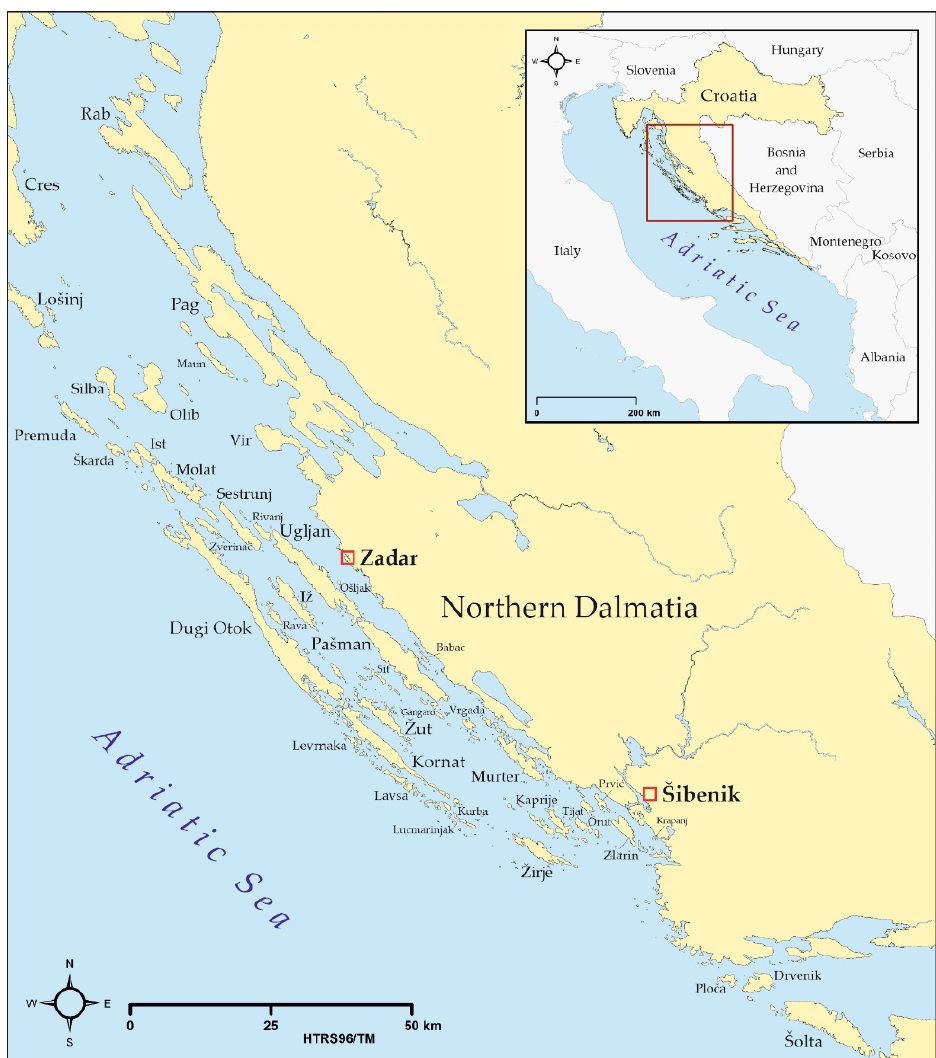
Figure 1. The geographical location of the northern Dalmatian islands .